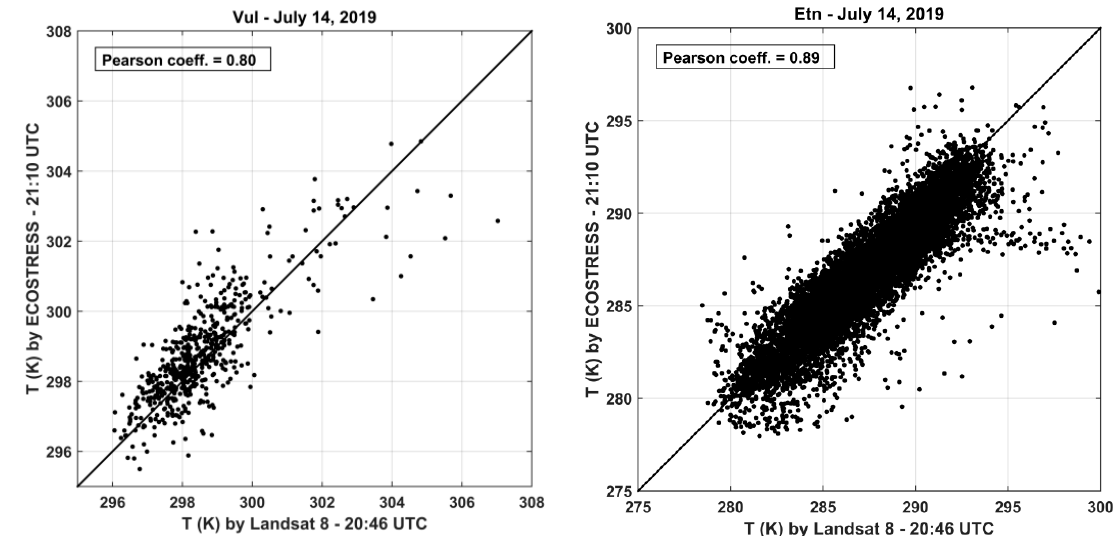
Figure 4. Scatter plots for comparison of LST–ECOSTRESS vs. L8. The black line is the bisector.